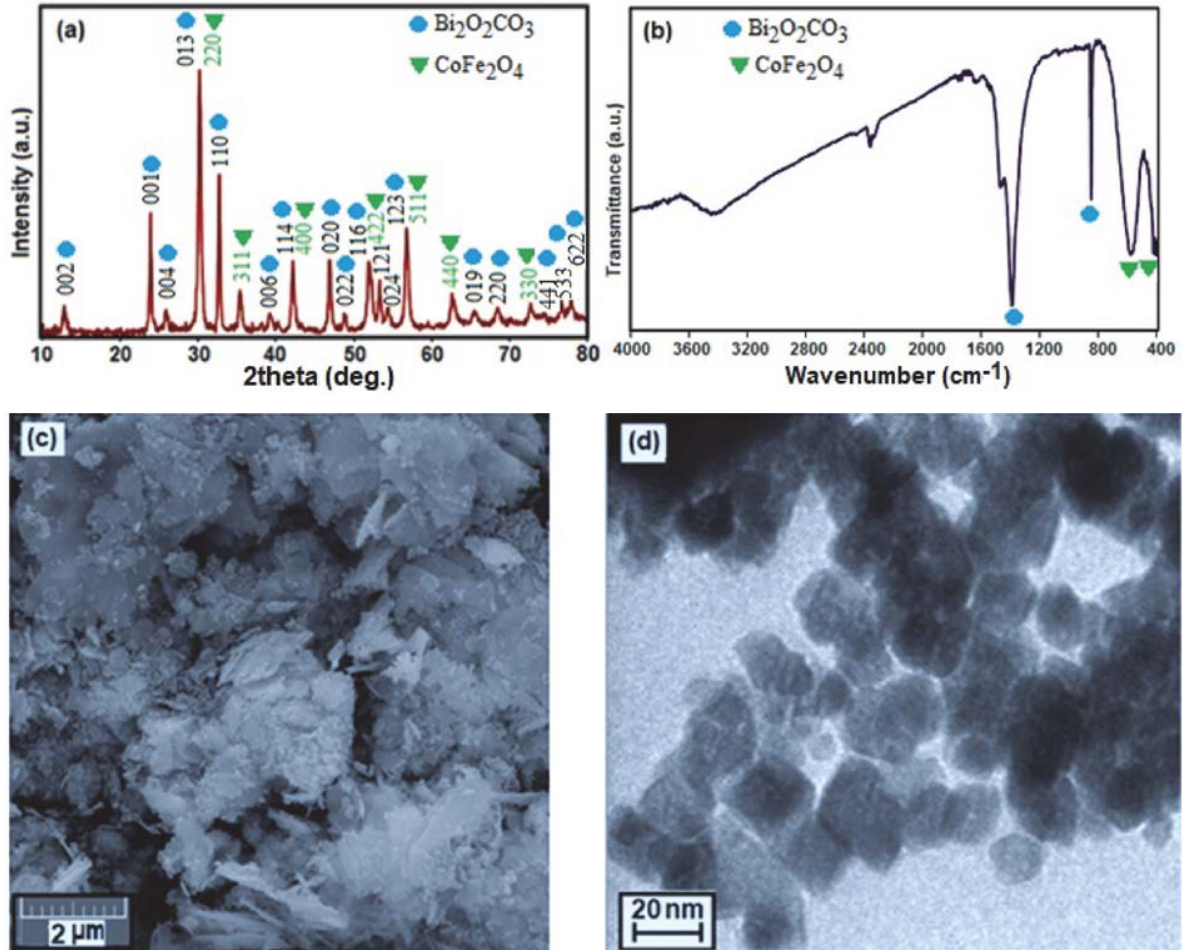
Figure 15. (a) XRD pattern, (b) FT-IR spectrum, (c) SEM image, and (d) TEM image of the recovered Bi 2 O 2 CO 3 /CoFe 2 O 4 30% nanocomposite after the 5 th run.